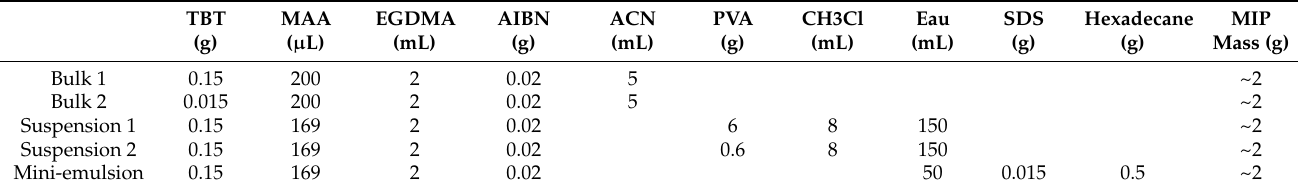
Table 1. Amount of chemical reagents used during